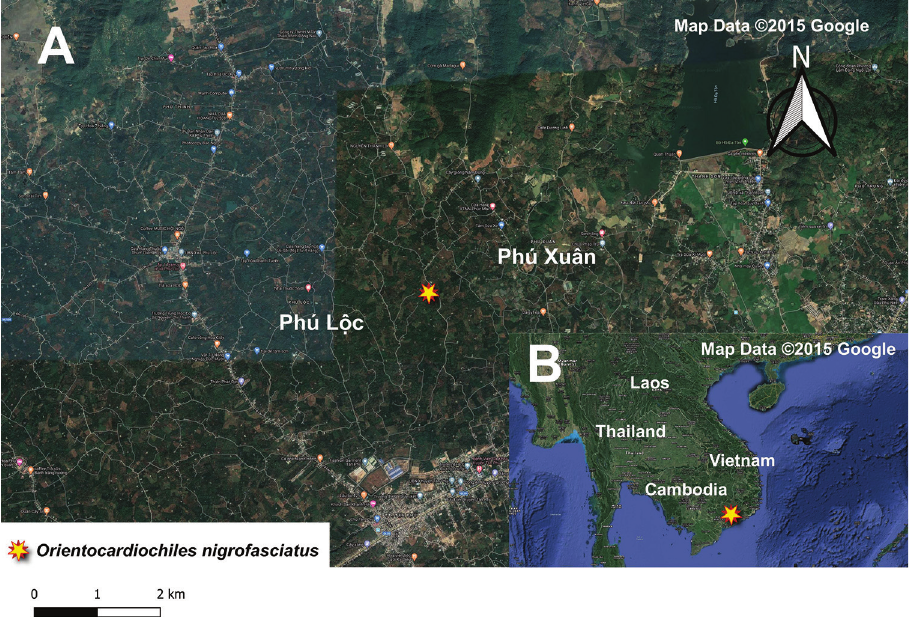
Figure 6. A Distribution map of Orientocardiochiles nigrofasciatus sp. nov. in Cat Tien NP B distribution map of O. nigrofasciatus sp. nov. in